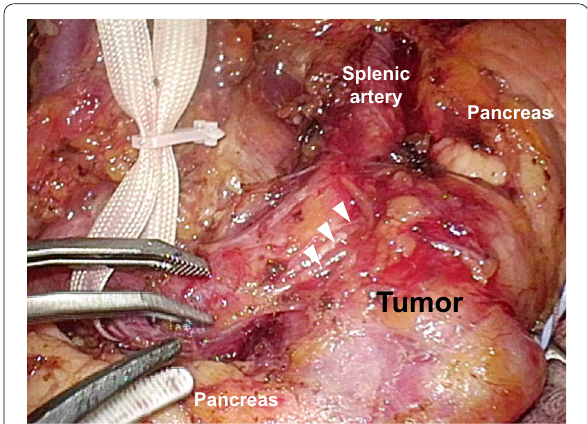
Fig. 4 Intraoperative photograph after taping the splenic artery. The tumor was observed at the body and tail of the pancreas and was tightly connected to the splenic plexus (triangles)